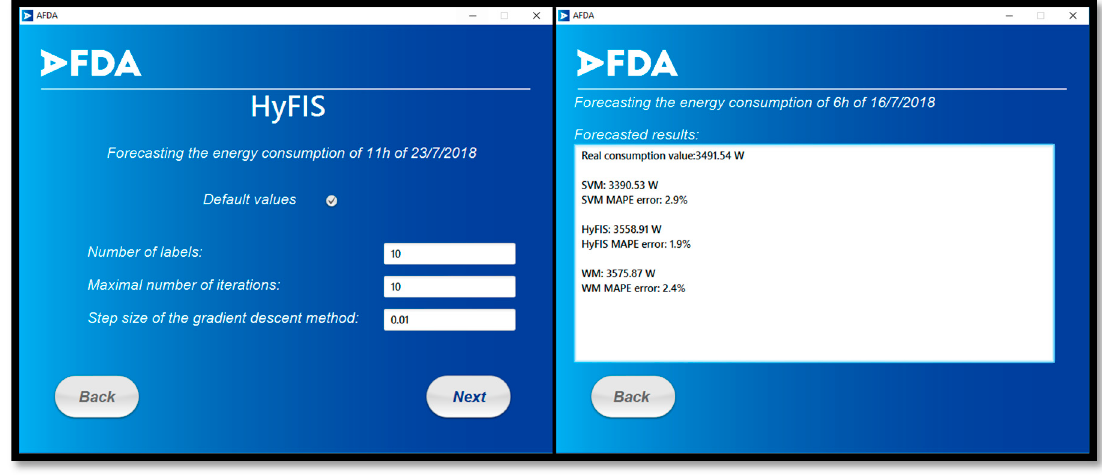
Figure 11. The method creation and results presentation pages.